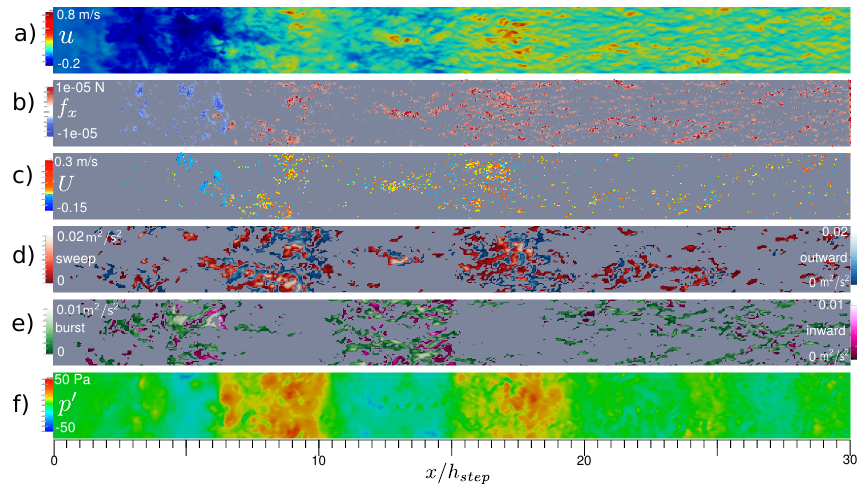
, divided by the total bx